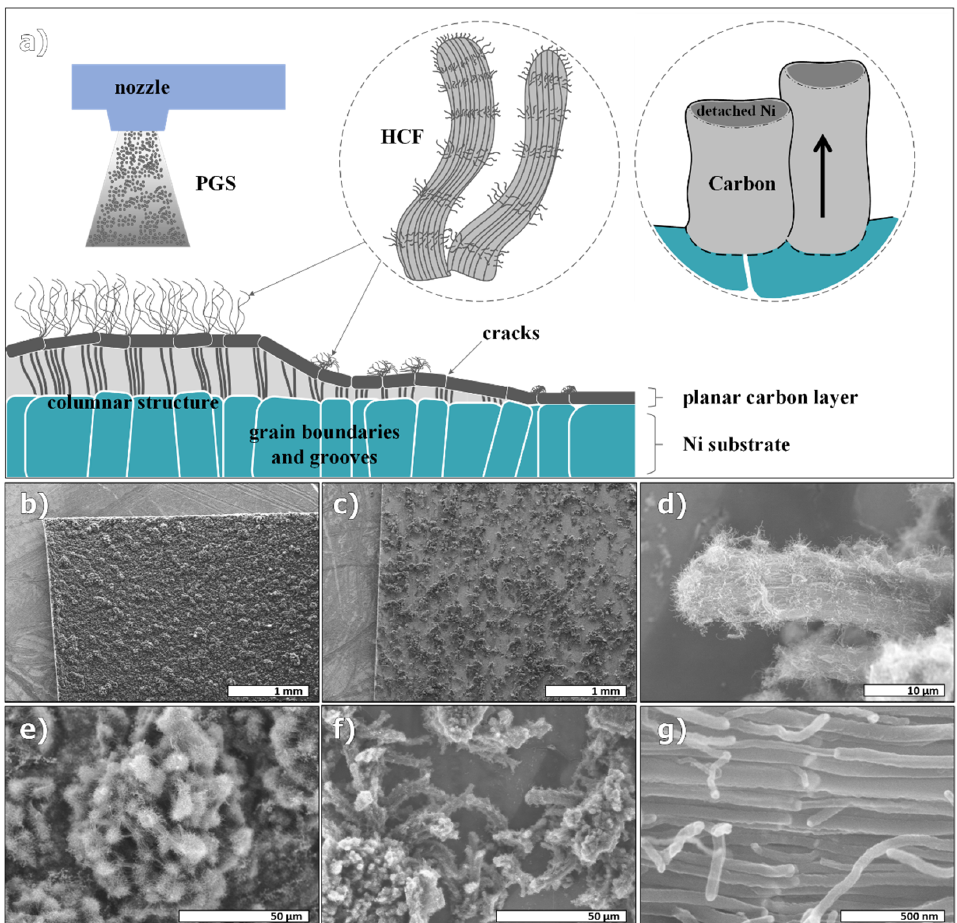
Figure 2. Images of the HCFs grown on a Ni substrate. ( a ) Sketch of the formation of HCFs across different regions of the substrate. ( b , e ) HCFs grown under the nozzle where there is a major accumulation of precursor. ( c , f ) Region of the substrate where there is less concentration of precursor, characterized by the emerging fiber bundles from cracks and grooves on the planar carbon layer. ( d , g ) Bundle of HCFs comprising non-smooth fibers of relative regular diameters. Segments with ending metal particles can be observed across the growth axis.